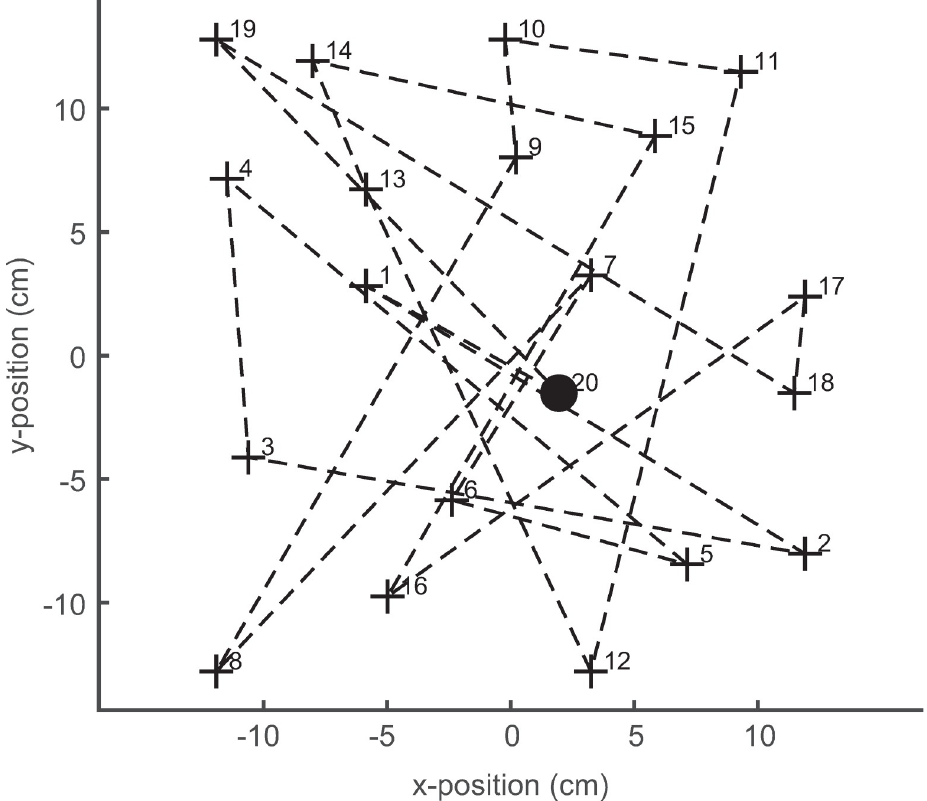
Fig 2. Illustration of the target sequence to be learned. The start position (solid circle) was identical with the last of the 20 target positions (crosses). In relation to the image size, the crosses are shown here twice as large as in reality. Each target was shown alone on the homogeneous background at an inter-target interval of 1.2